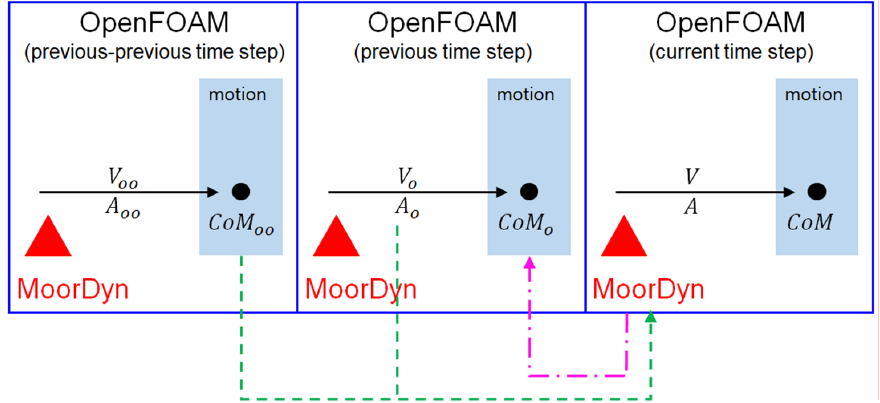
Figure 4. Concept of delayed coupling between OpenFOAM and MoorDyn: V and A are the velocity and the acceleration in the current timep step, respectively; The subscripts o and oo indicate the previous time step and the previous-previous time step, respectively.